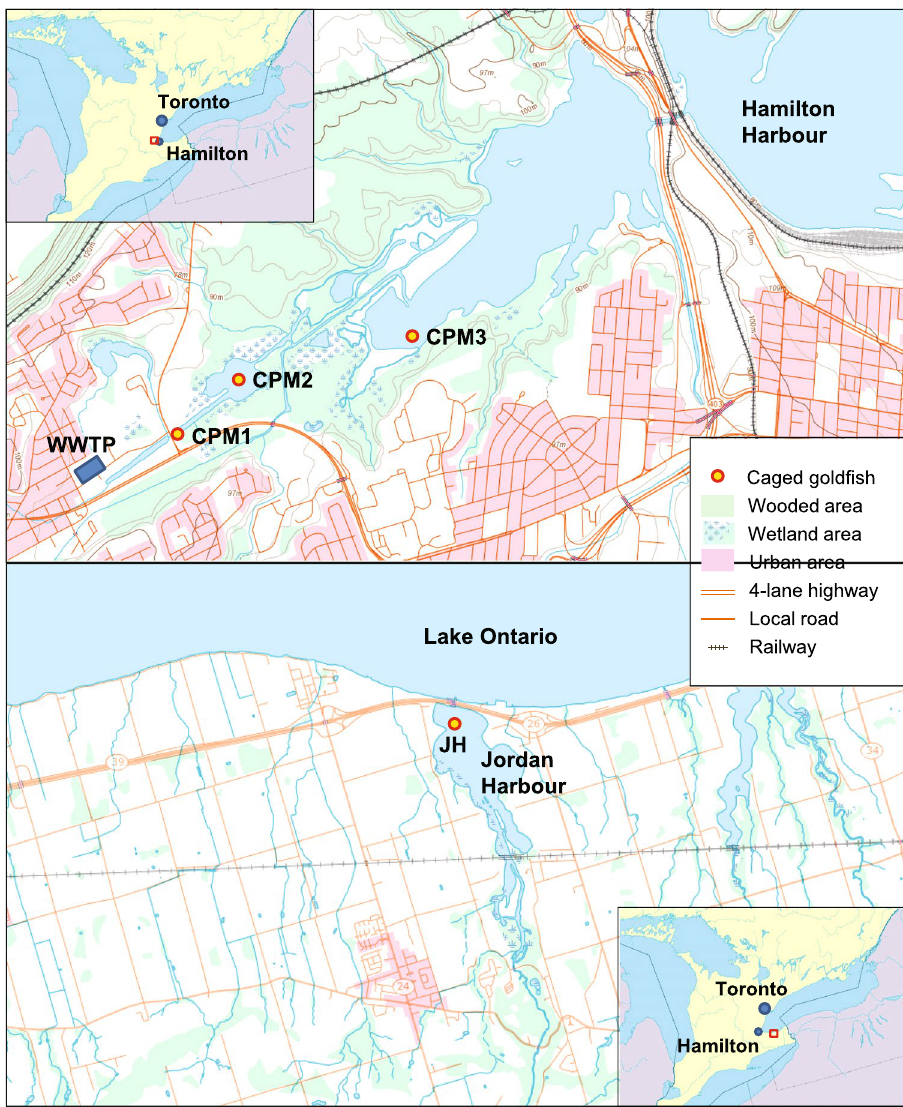
Figure 1. Caging locations in Cootes Paradise Marsh (CPM1, CPM2, and CPM3) and at Jordan Harbour (JH), Ontario, Canada. The base map is from the Atlas of Canada (with permission of Natural Resources Canada,